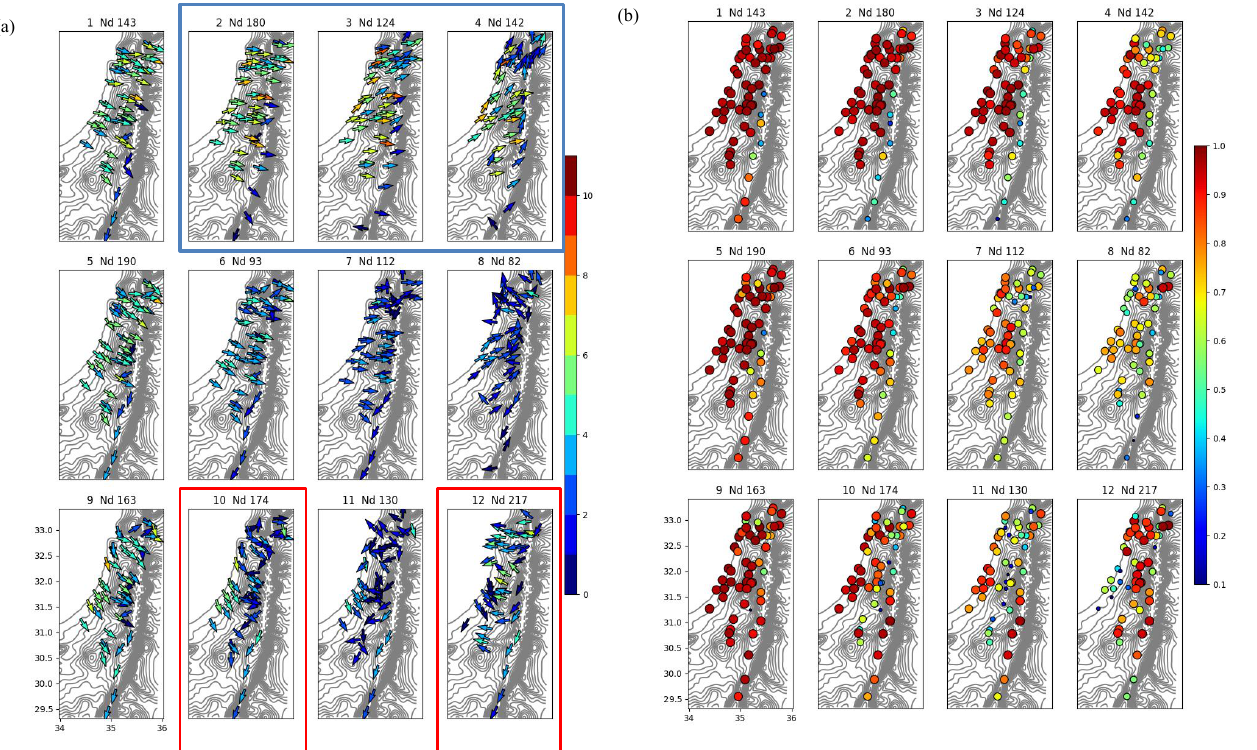
Figure 2. 12:00UTC winter, spring and autumn. (a) Average surface wind [ms − 1 ] patterns and (b) S -steadiness parameter. These values were calculated according to 4 × 3 SOM classification. The node number and the average (over the 53 stations) number of events, Nd, are shown at the top of each sub-figure. Red lines designate strong eastern wind regimes. Blue lines designate strong western wind